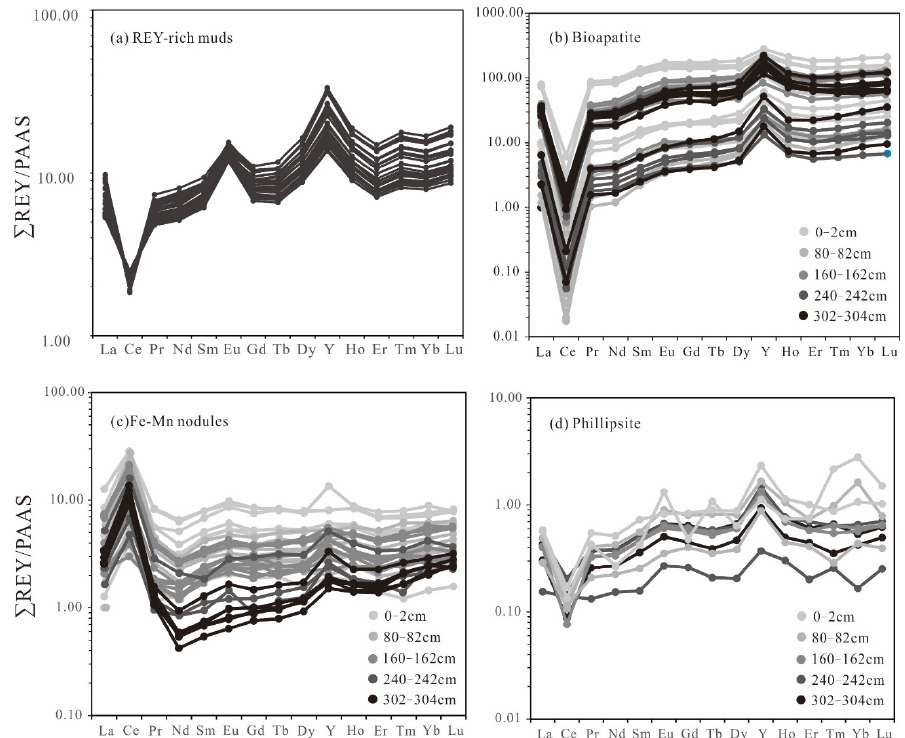
Figure 6. Post-Archean Australian Shale (PAAS)-normalized REY patterns for ( a ) REY-rich muds, ( b ) bioapatite, ( c ) Fe-Mn micronodules, and ( d ) phillipsite. Normalizing values are from [31].